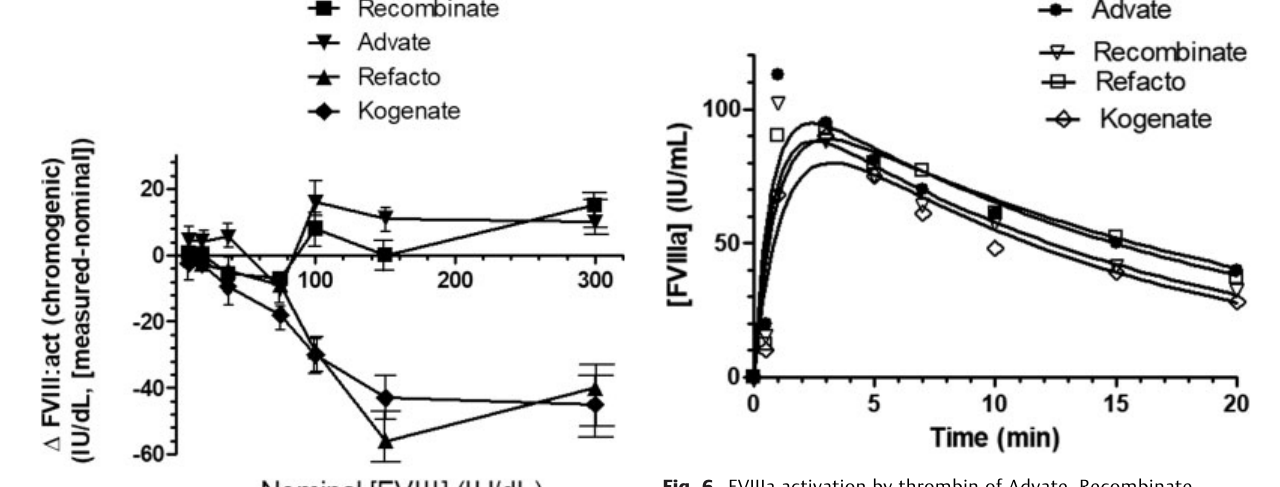
Fig. 6 FVIIIa activation by thrombin of Advate, Recombinate, Kogenate, and Refacto AF. The continuous lines were drawn using the best- fi t parameters [FVIII] max , k 1 , and k 2 of Eq. 2 listed in ► Table 2 . In all cases, FVIII preparations were used at 100 IU/dL and thrombin at 20 nM. Experiments were performed in duplicate using different lots of the products (SD: 6 (cid:4) 2%), and average values are shown. SD, standard deviation.